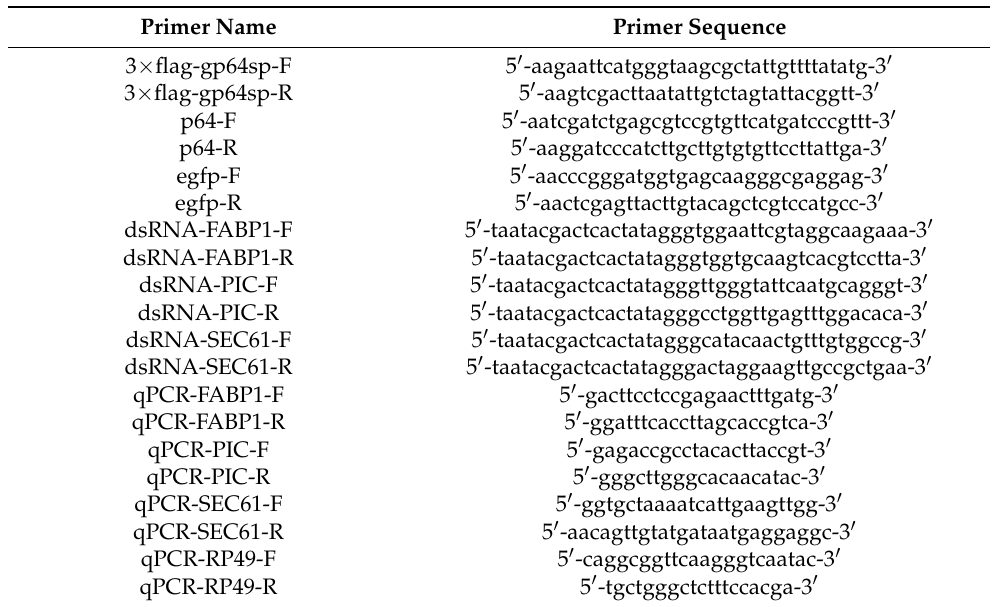
Table 1. Primers used in this study.